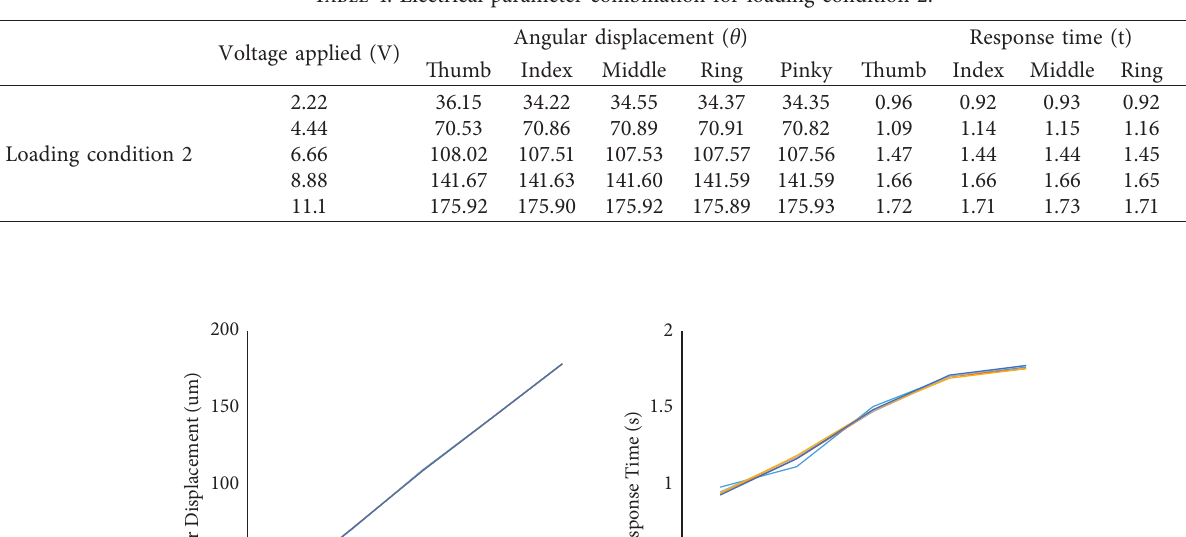
Table 4: Electrical parameter combination for loading condition